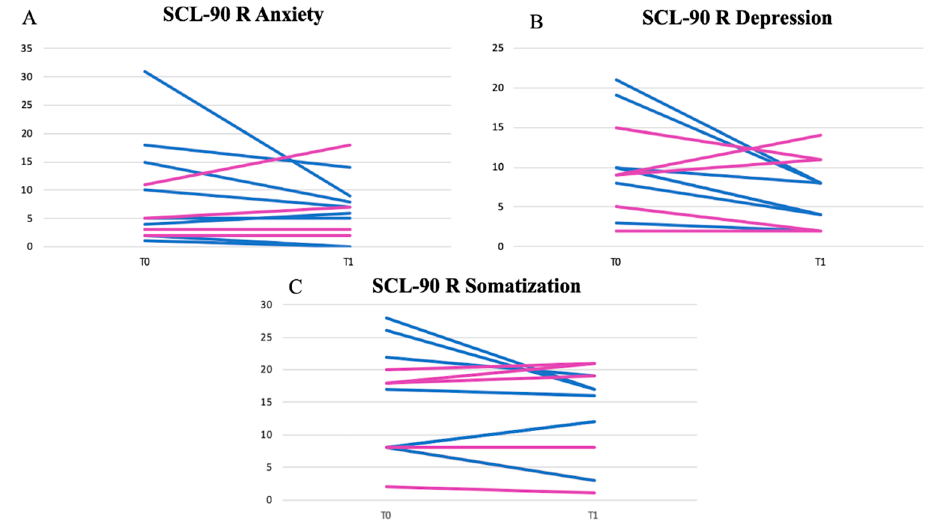
Figure 3. Results of anxiety ( A ), depression ( B ) and somatization ( C ) spheres of SCL-90 questionnaires of OFS group. Legend: blue lines for male patients; pink lines for female patients.